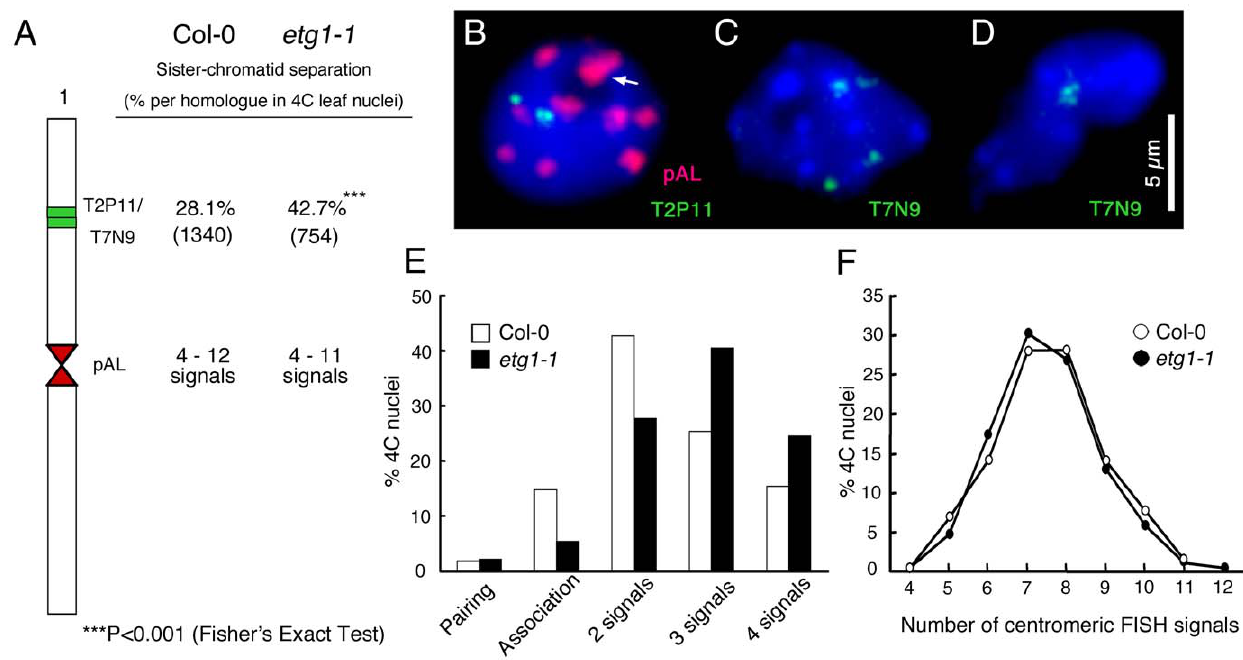
Figure 2. Requirement of ETG1 for establishment of sister chromatid arm cohesion. (A) Percentage of positional separation frequencies per homologous chromosome (number of investigated nuclei in parentheses) analyzed in wild-type (Col-0) and etg1-1 mutant plants after FISH with the labeled T2P11 or T7N9 BACs from chromosome 1. The FISH probe pAL detects the centromeric 178-bp repeats. (B–D) Structural arrangement of FISH signal positions in 4C nuclei counterstained with DAPI. (B) Positional alignment (T2P11) at both chromosome 1 homologs. Two of 10 centromeric signals associated (arrow). (C) Positional sister chromatid separation at both homologs. (D) Positional association of both homologs. (E) Percentage of sister chromatid alignment/separation frequencies analyzed in wild-type (Col-0) and etg1-1 . (F) Identical frequencies of centromere- specific FISH signals in wild-type and etg1-1 nuclei.